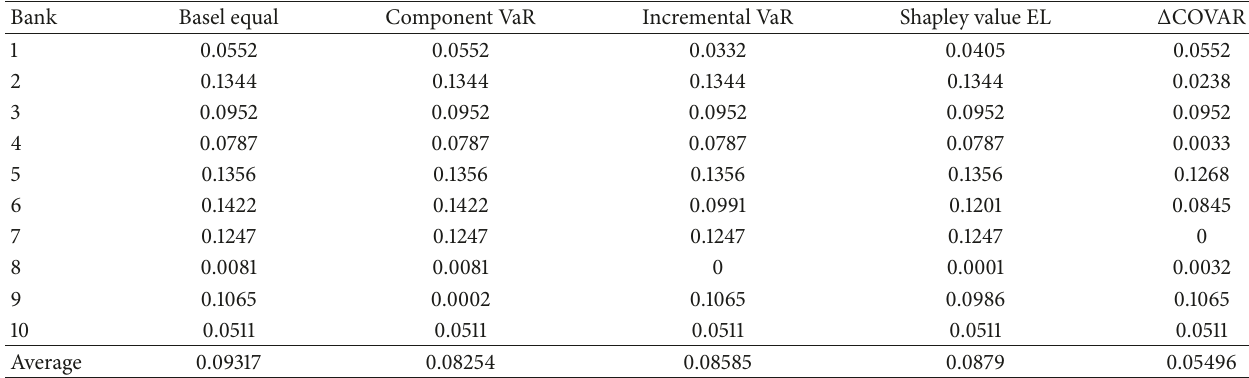
Table 3: Individual bank default probabilities under the macroprudential capital requirements in 2008.